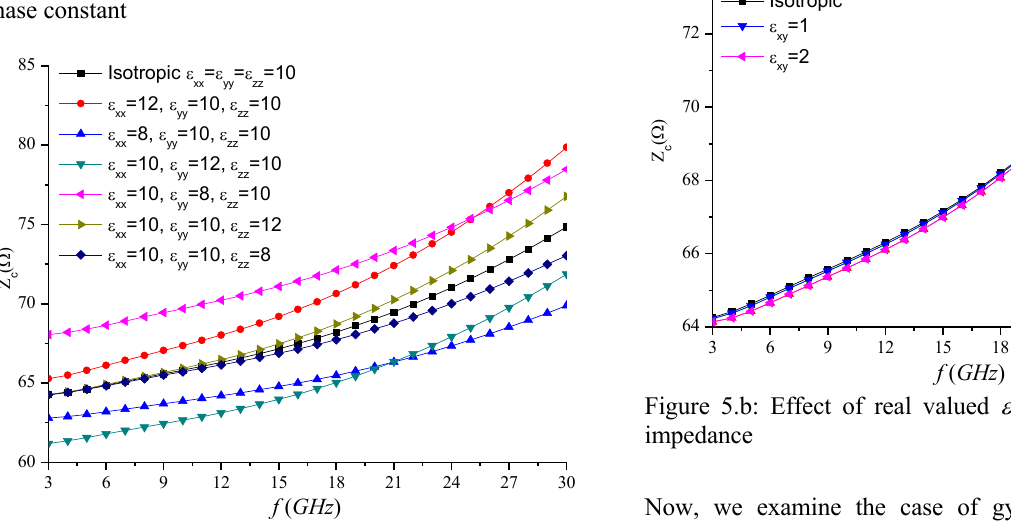
Figure 4.b: Effect of uniaxial anisotropy on the